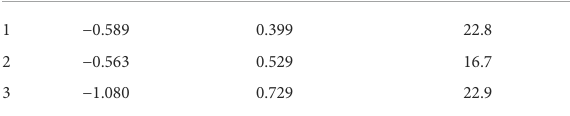
TABLE 4 Identi fi ed results of the simpli fi ed 14-generator system.